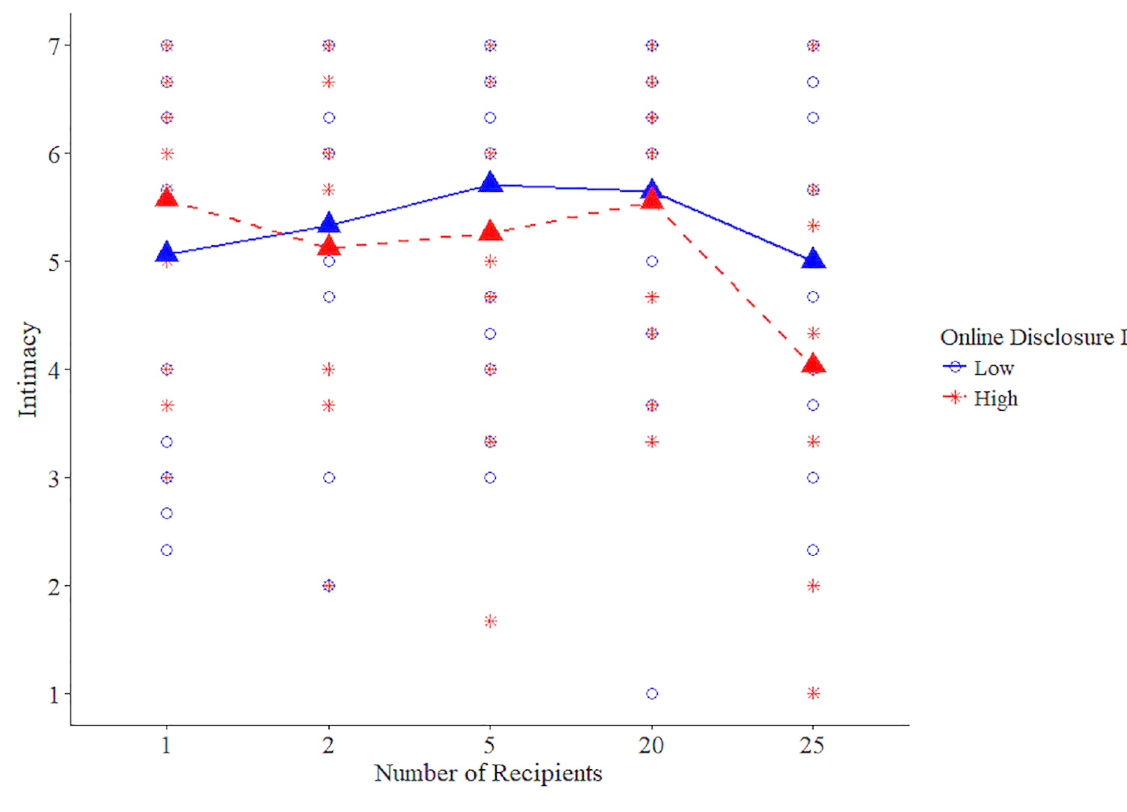
Fig 2. Study 4 means for intimacy in each of the prime